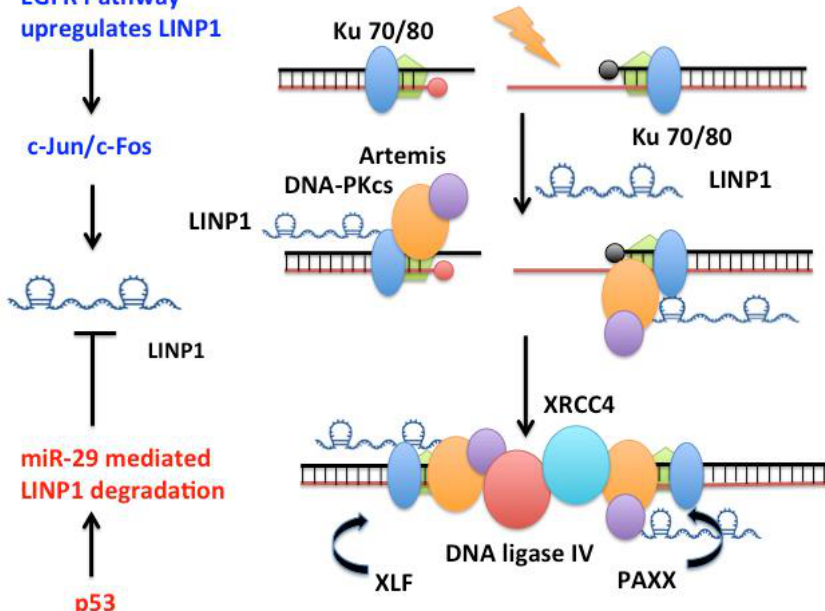
Figure 2. LINP1 is a 917 nt long RNA that promotes the assembly of NHEJ factors to enhance